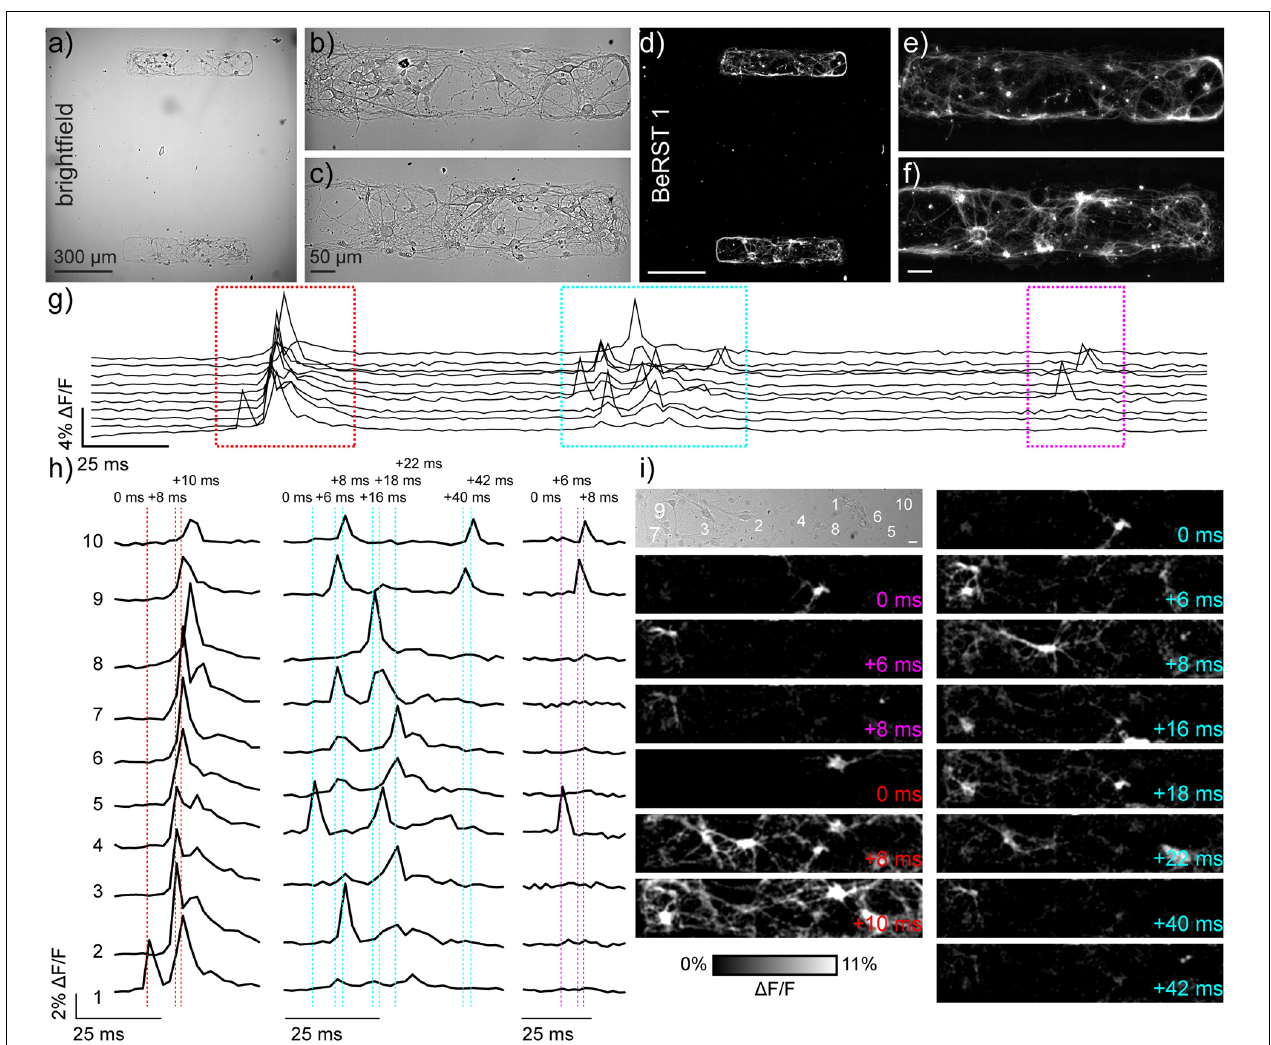
FIGURE 1 | Monitoring neuronal activity in patterned microislands of dissociated rat hippocampal neurons using BeRST 1. (a) Representative differential interference contrast (DIC) image of dissociated rat hippocampal neurons grown on patterned microislands. Higher magnification image of (b) upper and (c) lower microisland from panel (a) . (d–f) Corresponding BeRST 1 (500 nM) fluorescence images. (g) Plot of (cid:49) F/F vs time for a representative microisland culture stained with BeRST 1 and imaged at 500 Hz. (h) Expanded times scale for colored, boxed regions in panel (g) . Dashed vertical lines and timing labels indicate relative timing of fluorescence intensity changes. (i) Transmitted light image of neurons recorded in panels (g,h) , with numbers indicating the neurons plotted in (g,h) . Images with colored time stamps are (cid:49) F/F images corresponding to single frames (2 ms exposure) from the recorded image sequence at the dashed vertical lines in panel (h) . Images have a 2 pixel Gaussian blur applied to aid visualization. Scale bar for (i) is 20 µ